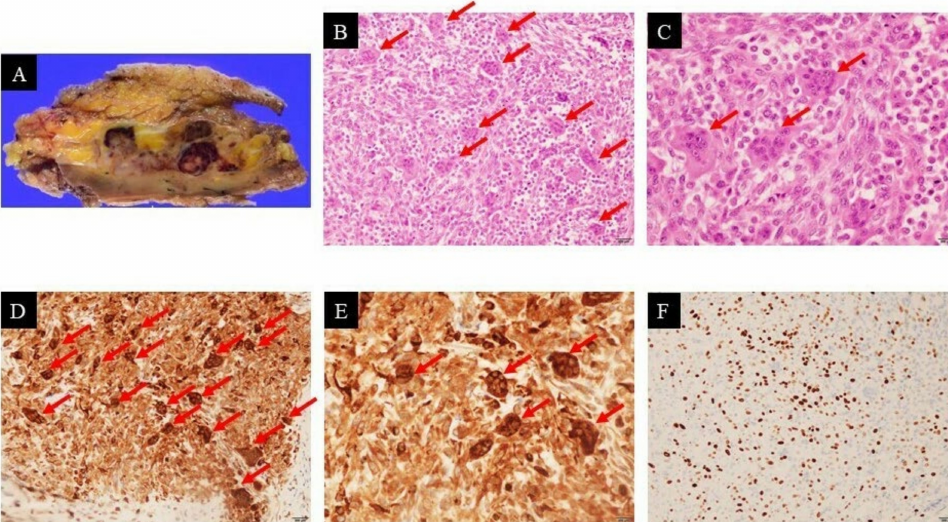
Figure 3. Pathological examination of the specimen confirmed giant cell tumor of soft tissue: resected specimen ( A ); hematoxylin–eosin staining ( × 200 ( B ), × 400 ( C ): The tumor was composed mainly of oval and spindle mononuclear cells (tumoral cells) and multinucleated giant cells (arrows)); immunohistochemical staining of CD68 showed cytoplasmic positivity ( × 200 ( D ), × 400 ( E ): Oval and spindle mononuclear cells (tumoral cells) and multinucleated giant cells (arrows)); Ki-67 labeling index was high ( × 200 ( F